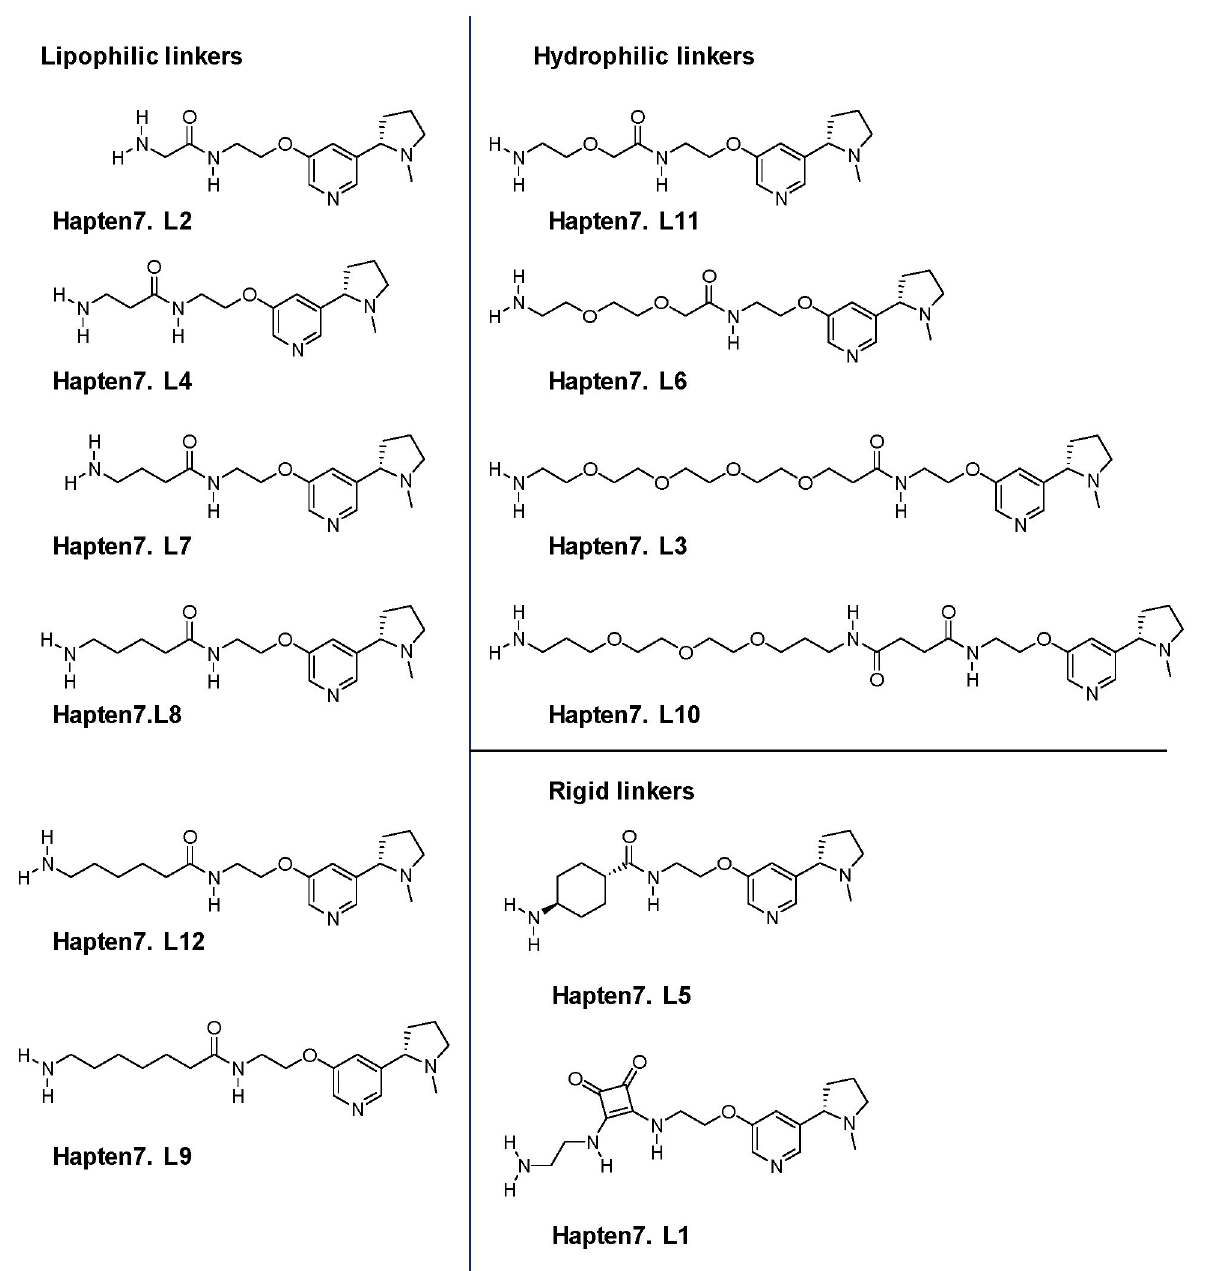
Figure 7. Structures of different linker-modified nicotine